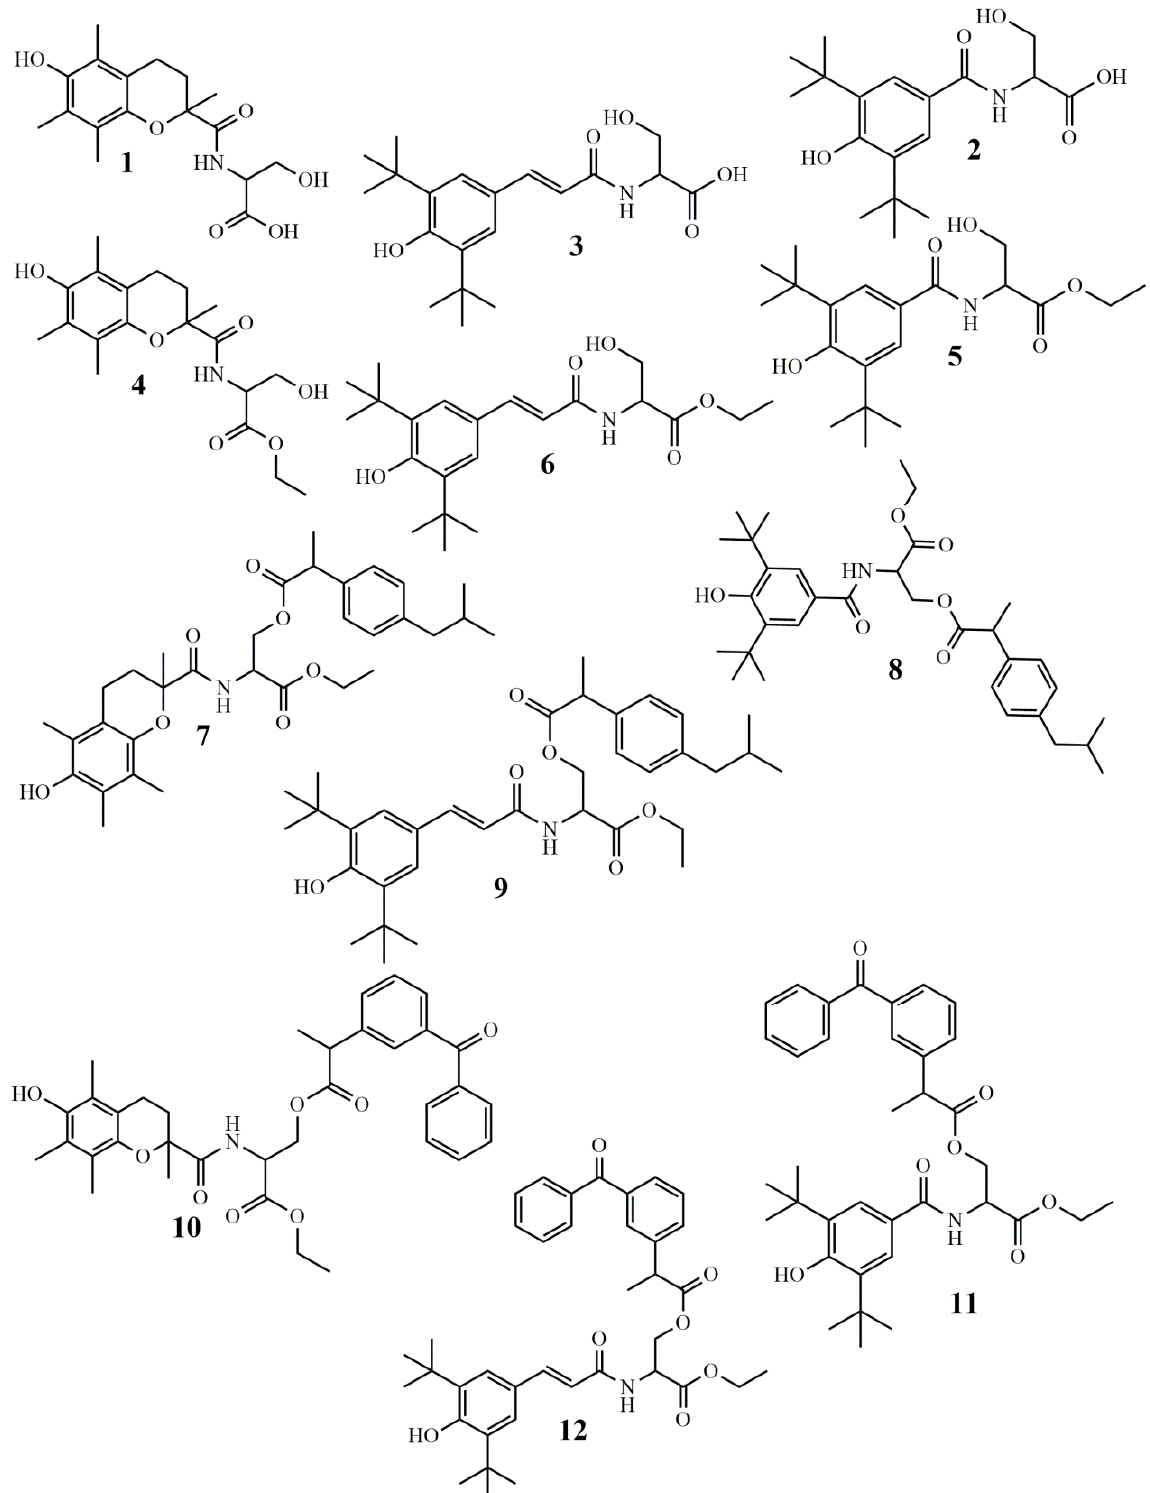
Figure 1. The synthesized novel L-serine derivatives.